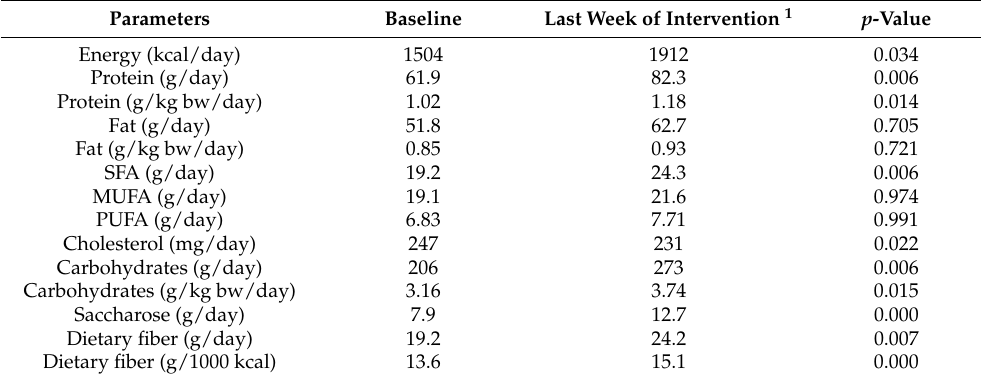
Table 7. Energy and macronutrient intakes at baseline and after the dietary intervention among study participants ( n = 29).